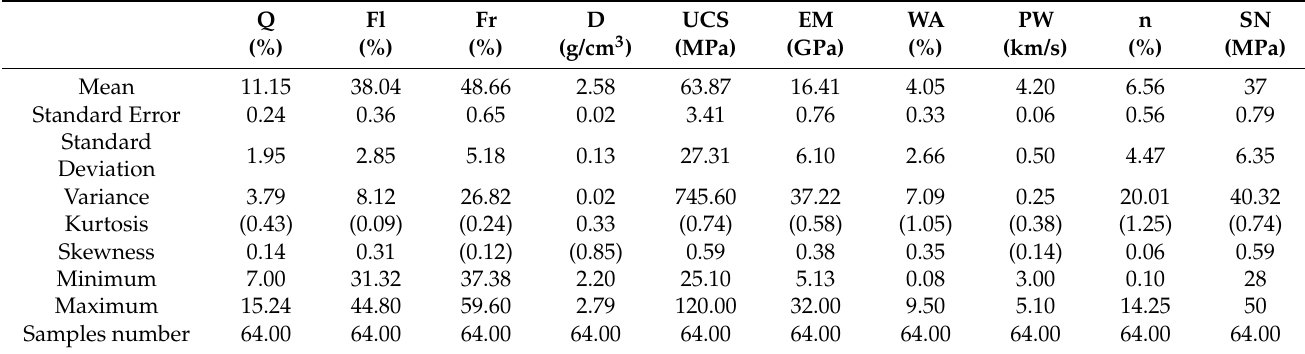
Table 2. Measured properties on the